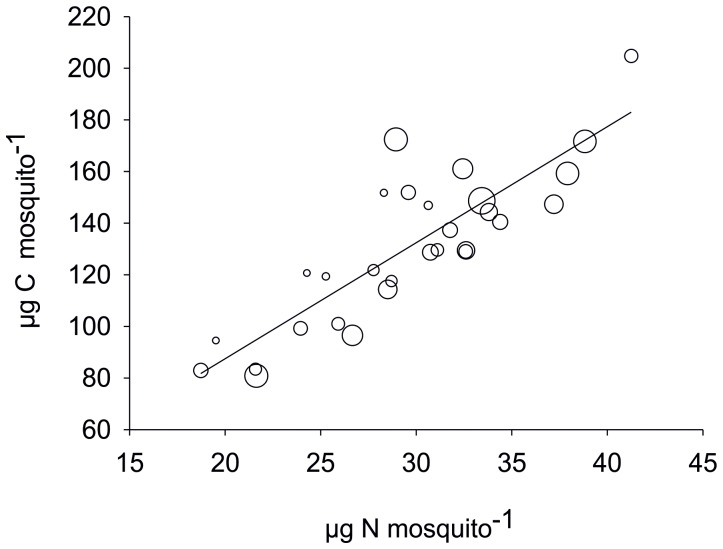
Regression analysis of average (n = 3) TBN against TBC, where bubble size represents TBP, Experiment 2.